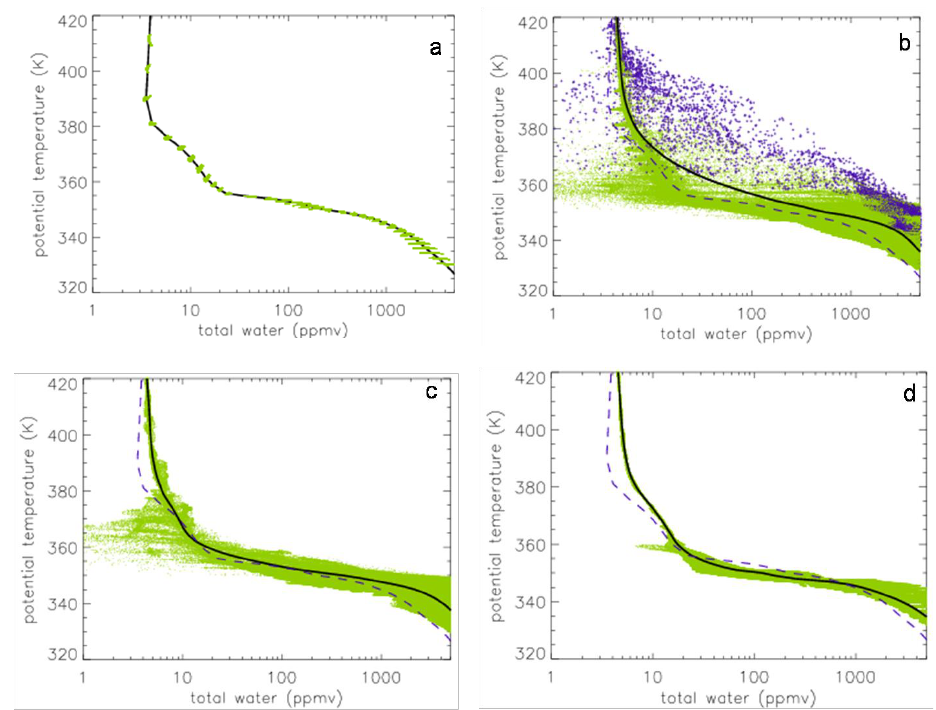
Fig. 13. Scattergram of total H 2 O/potential temperature within the Grid 3 domain of BRAMS at different times of the simulation for the Chad case. (a) Initial state at 18:00UT on 3 August. (b) 14:15UT on 4 August at the maximum of the overshooting activity. (c) 15:55UT after the overshooting activity. (d) 21:00UT after the convective activity. The black solid line is the mean mixing ratio within the grid. The blue dashed line is the initial mean mixing ratio. Purple crosses highlight grid points in the overshooting plume area (latitude from 11.95 ◦ N to 12.06 ◦ N and longitude from 20.9 ◦ E to 21.1 ◦